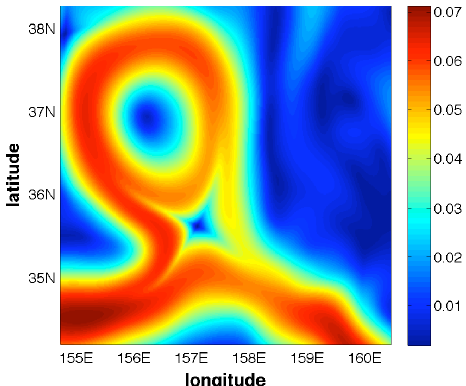
Fig. 4. A representation of the function M over a small oceanic area on 2 May 2003 for τ = 2 days. (Color version of a figure from Mendoza and Mancho,